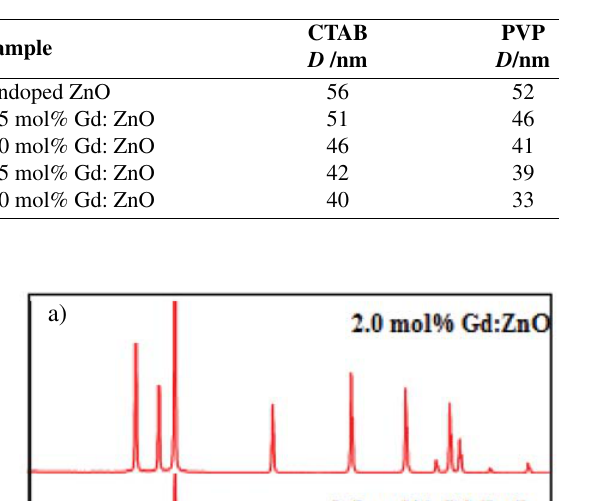
Table 2. Crystallite size of undoped and Gd doped ZnO calculated by Williamson-Hall method.